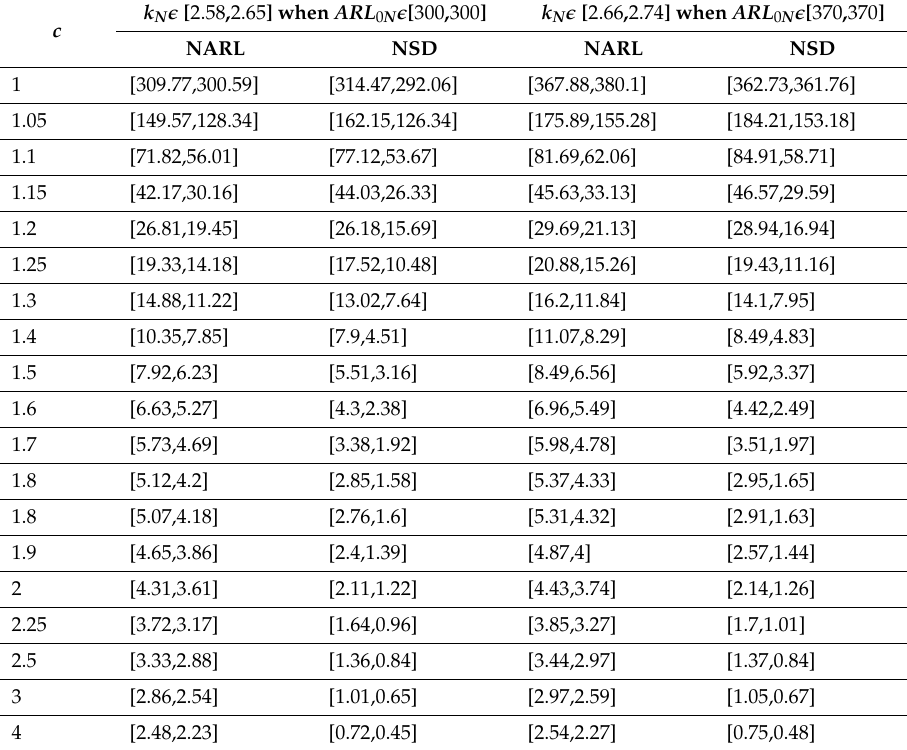
Table 2. The neutrosophic average run length NARL when n N (cid:15) [3, 5] and λ N (cid:15) [0.08,